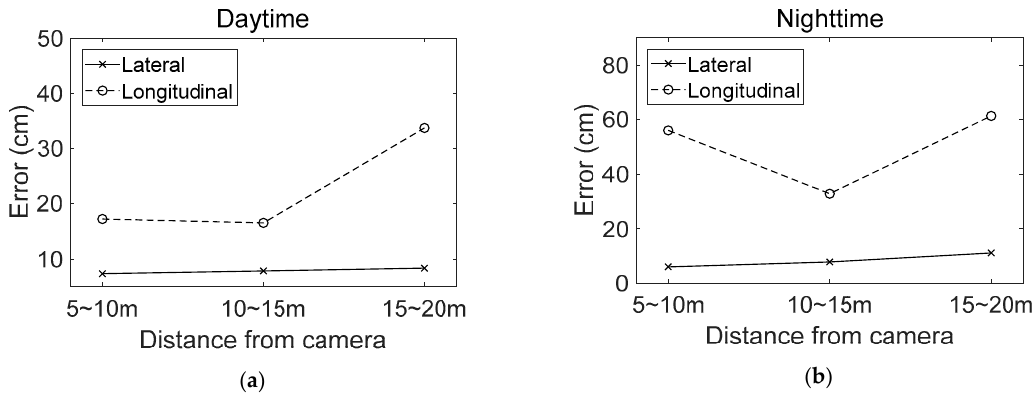
Figure 15. Changes of position errors according to the distance from the camera, ( a ) Daytime; ( b ) Nighttime.